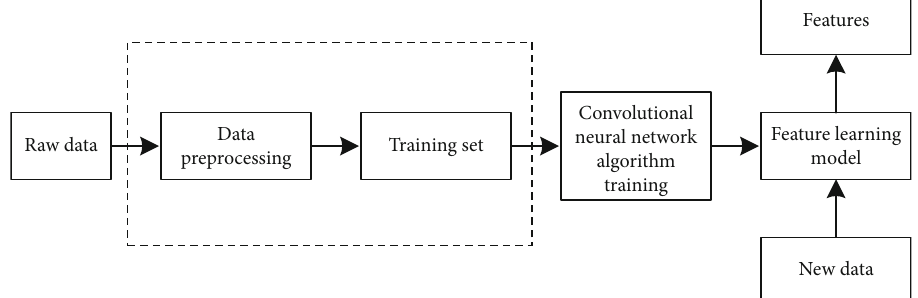
Figure 1: Collection of human health information characteristics after sports